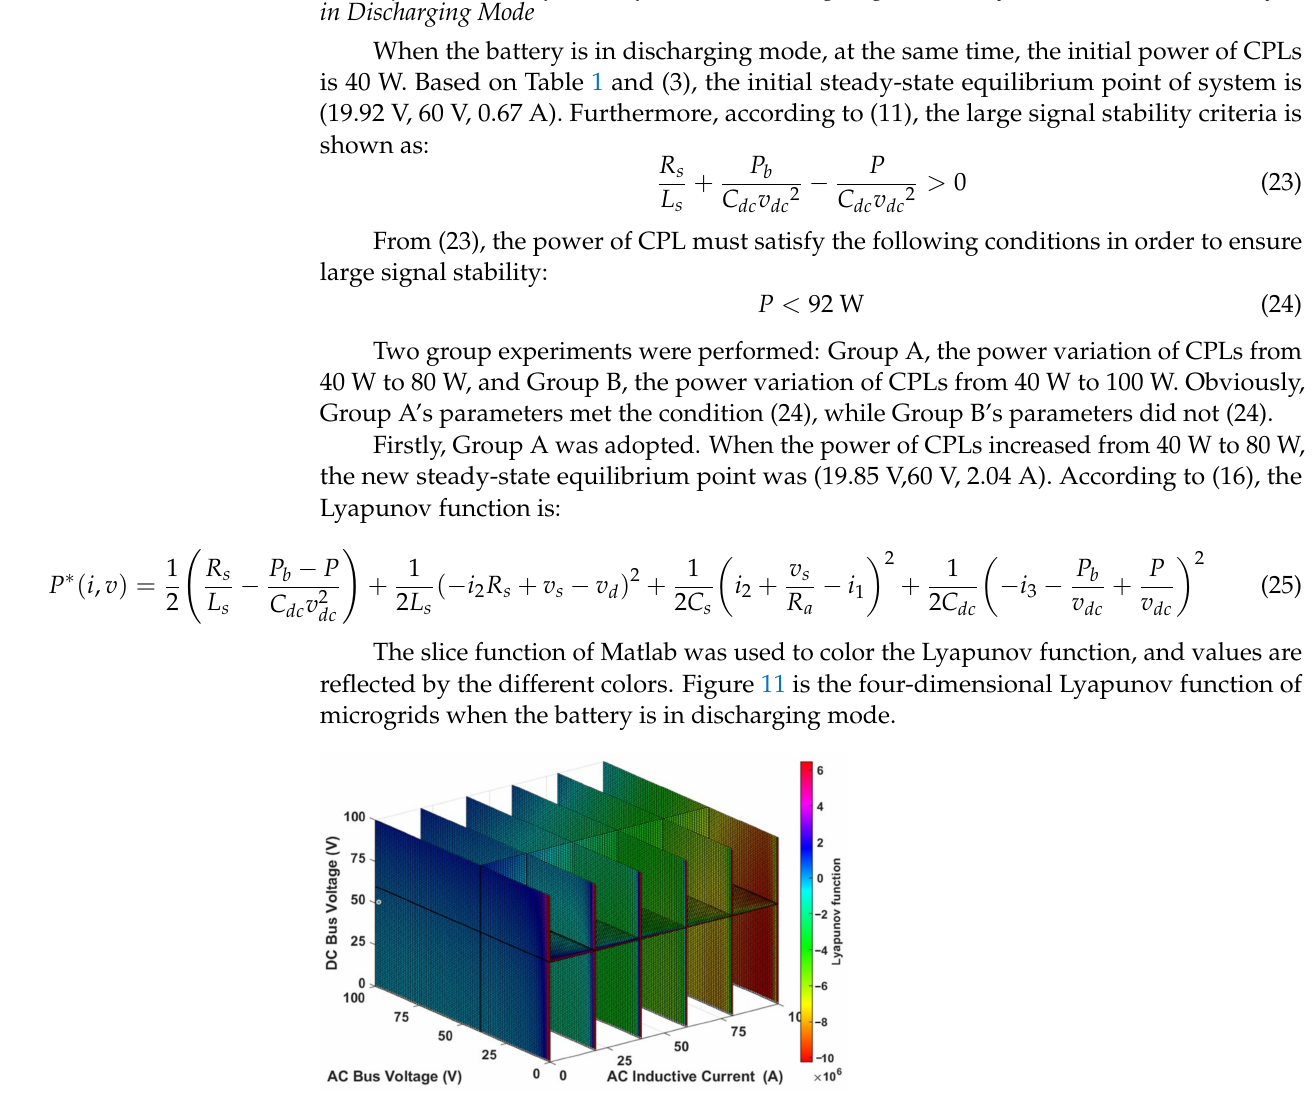
Figure 11. Four-dimensional graph of Lyapunov function of microgrids with the battery in discharg- ing